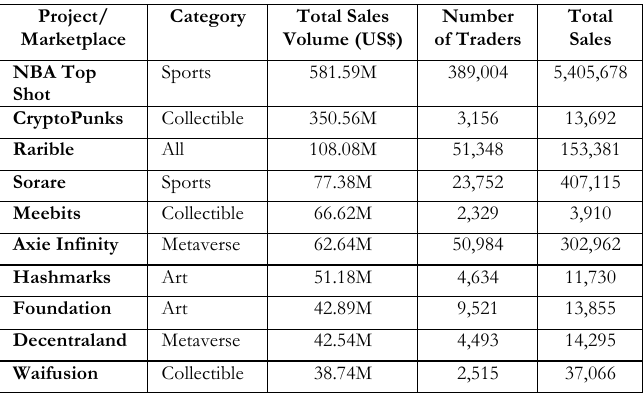
Table 1: Top 10 NFT Projects Sorted by Total Sales